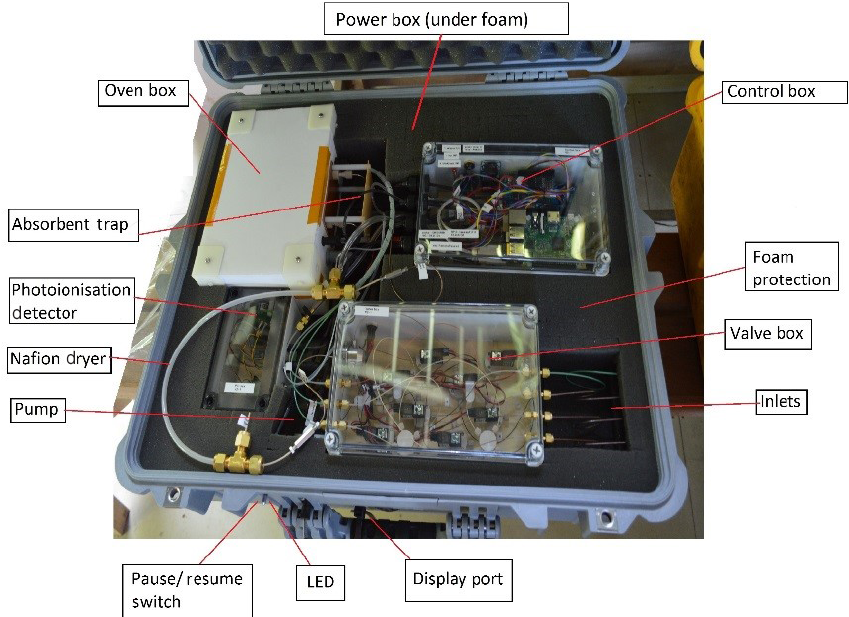
Figure 1. Interior of the iDirac showing the modular design of its component parts inside the main Peli case (22cm × 61.6cm × 49 . 3cm)